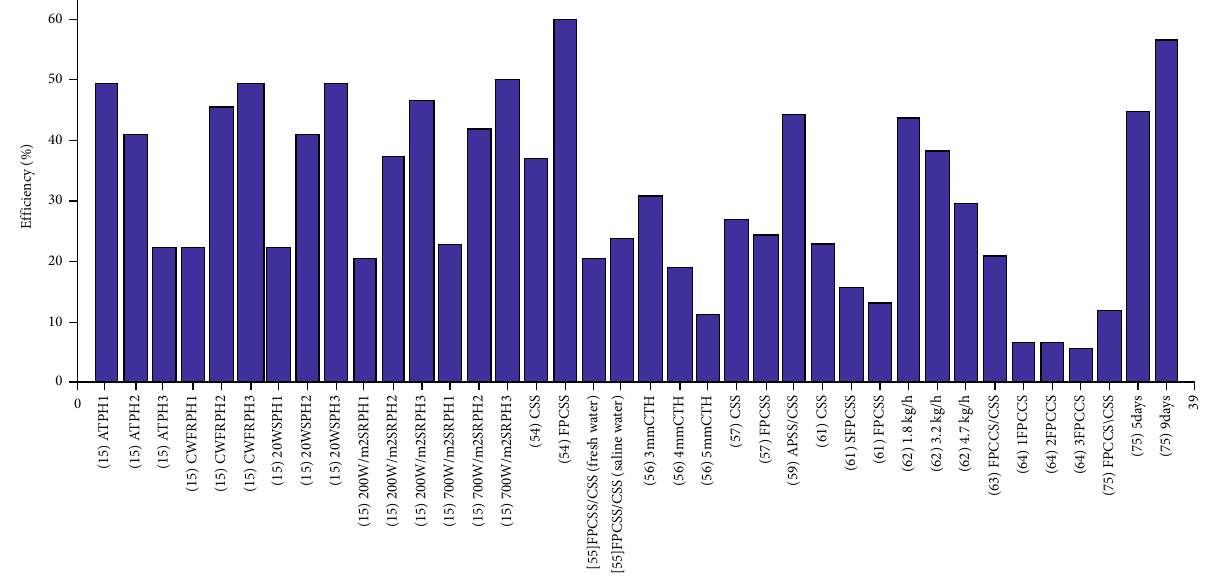
Figure 17: E ffi ciency of di ff erent types of solar